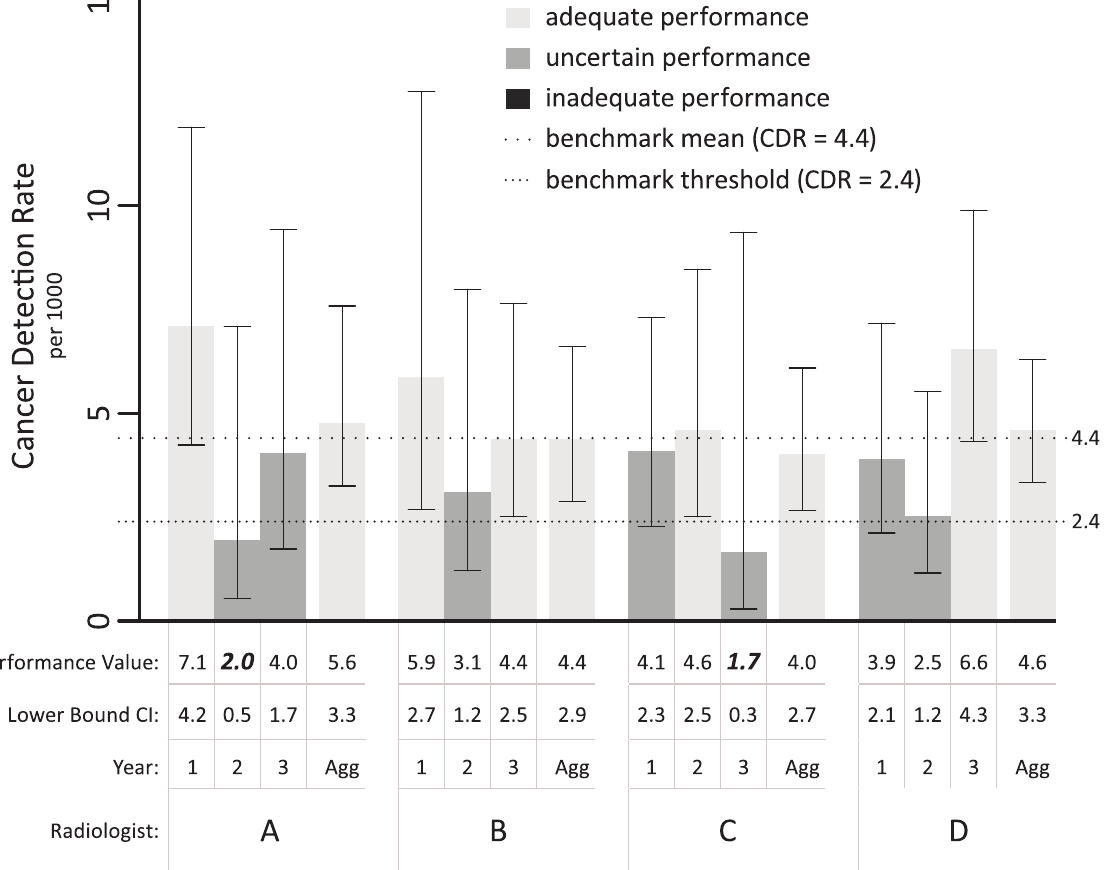
Figure 3. Annual observed performance values as compared to aggregated data. Annual CDR for each individual radiologist are shown on this bar graph with performance values and lower bound 95% CI summarized below the bar graph. The fourth bar for each physician represents performance over the 3 years of the study period aggregated (‘‘Agg’’) into a consolidated performance metric. Performance values in th first row in italics and bold represent performance values that would be characterized as inadequate using previously published benchmark thresholds.